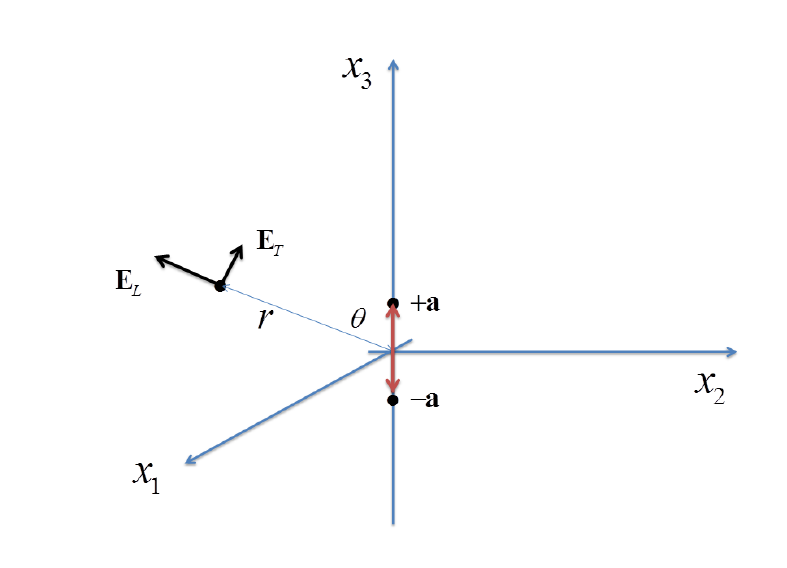
Figure 1. Geometrical setting for the calculation of the extra-current I (17) produced by the failure of local conservation. The charge q oscillates between points placed on the x 3 -axis, at − a and + a . The field is computed in the plane x 1 – x 3 , with angle θ = 45 ◦